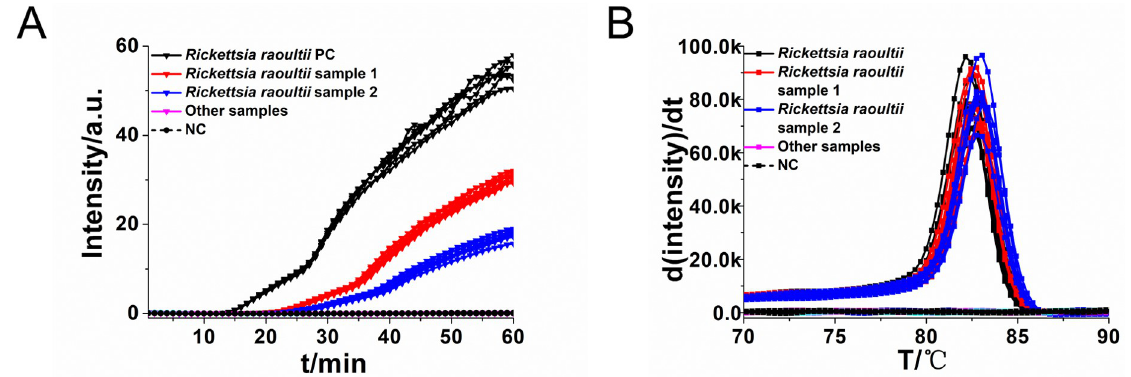
Fig 5. Real time RO-CDA assay. Real-time RO-CDA reactions were carried out at 60˚C for 60 min. (A) Real-time RO-CDA for R . raoultii DNA positive controls ( Rickettsia PC), different R . raoultii samples (HLBE 407 and 408), other rickettsial and non rickettsial samples, ( Rickettsia sibirica , Anaplasma ovis , Klebsiella pneumoniae , Pseudomonas aeruginosa , Escherichia coli , Shigella , Staphylococcus aureus , Vibrio parahaemolyticus , Listeria monocytogenes and Streptococcus agalactiae ) and no template control (NC). (B) Melting curve analysis of the RO-CDA products by real-time PCR. PC, positive reaction with the template; NC, negative control reaction without the template.